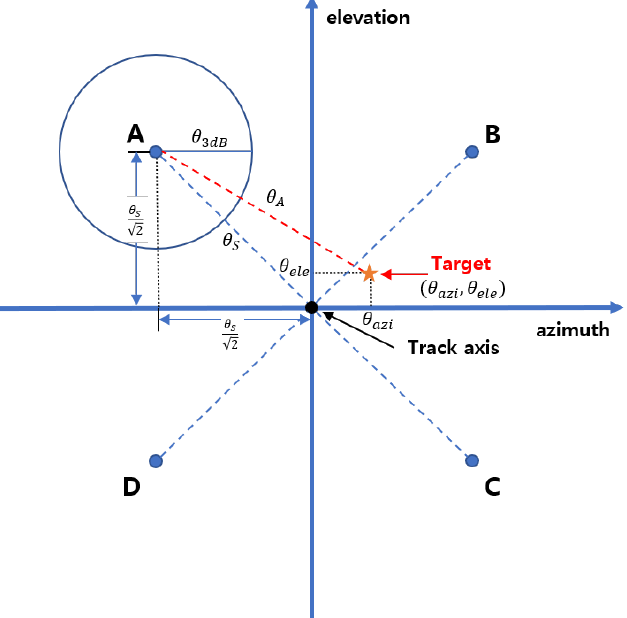
Figure 1. Tracking center and angle error of monopulse